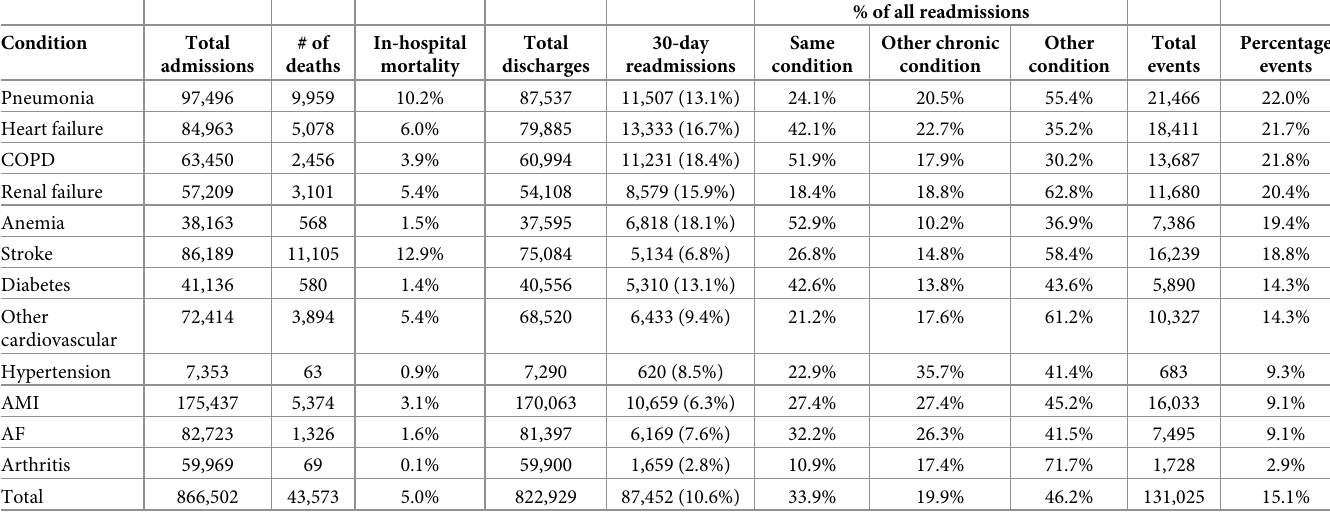
Table 3. Rate of in-hospital mortality, 30-day readmissions, percentage of conditions of readmissions and total events (combination of readmissions and deaths) in relation to the reason for index hospitalisation.